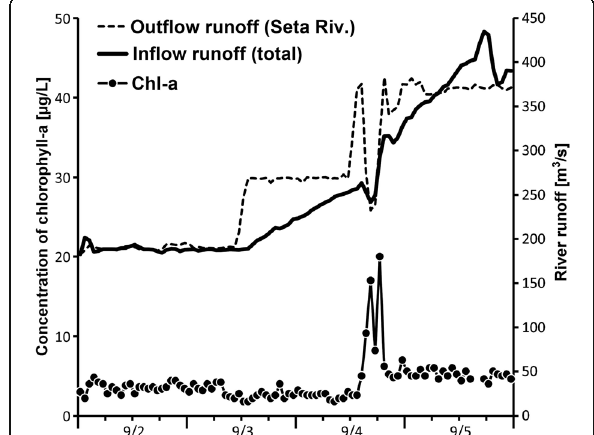
Fig. 7 Temporal variations in the total river runoff into/from Lake Biwa and the chlorophyll-a concentration observed at the OOCAOS located in the southern basin during the period of 2 – 5